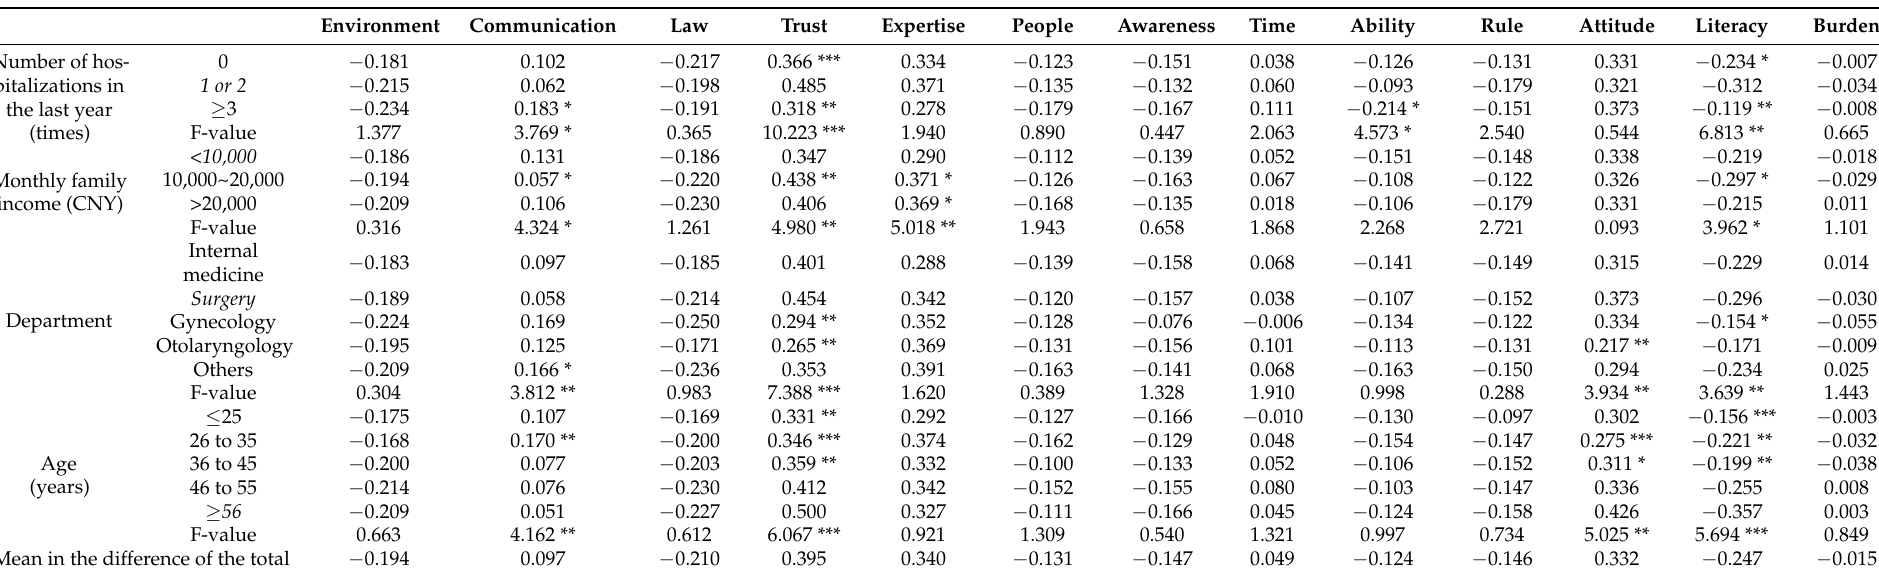
Table 6. Best-worst scores of subgroups with different inpatient departments, monthly family incomes, number of hospitalizations in the last year, and ages (results of the one-way multivariate analysis of